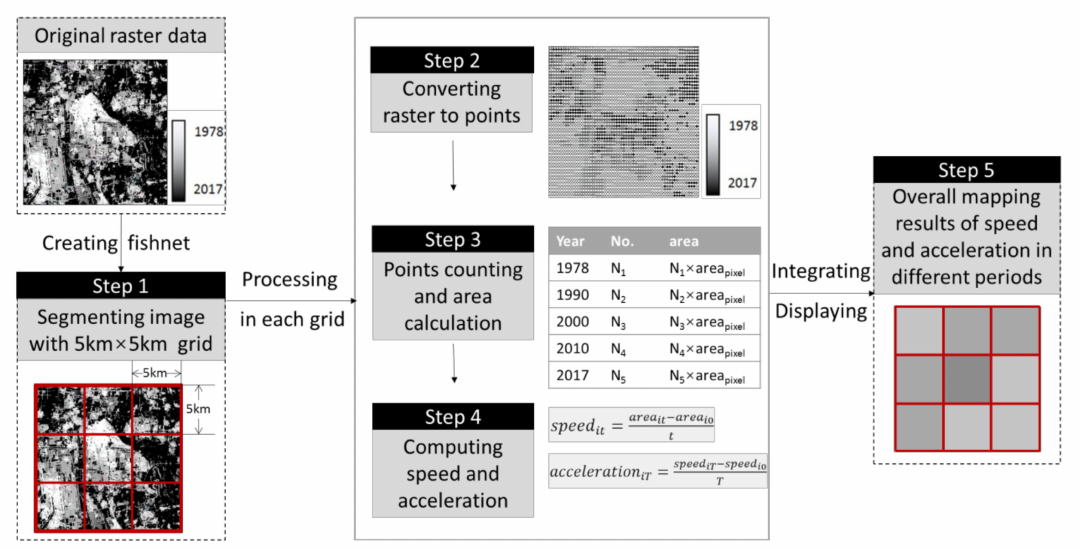
Figure 2. Mapping of speed and acceleration based on data